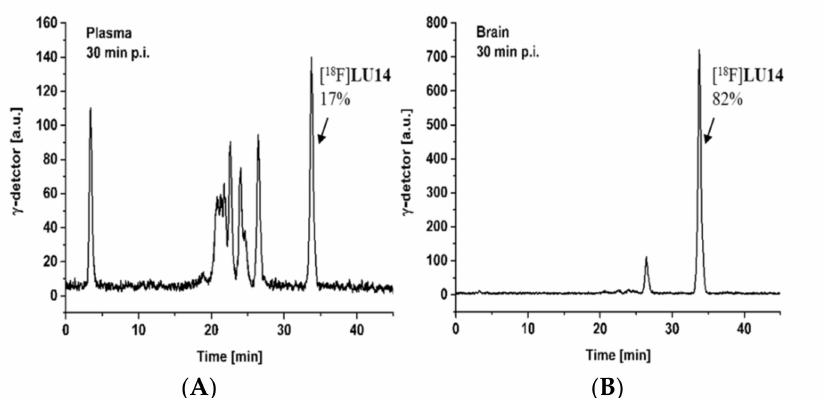
Figure 5. Analytical radio-HPLC chromatograms of the in vivo metabolism of [ 18 F] LU14 at 30 min p.i. ( A ) Plasma samples [extraction with MeOH/H 2 O (9:1); extraction yield: 91%] and ( B ) brain ho- mogenates [extraction with MeOH/H 2 O (9:1); extraction yield: 97%]. HPLC conditions: Reprosil-Pur C18-AQ (250 × 4.6 mm; 5 µ m); gradient mode (10-90-10% CH 3 CN/20 mM NH 4 OAc